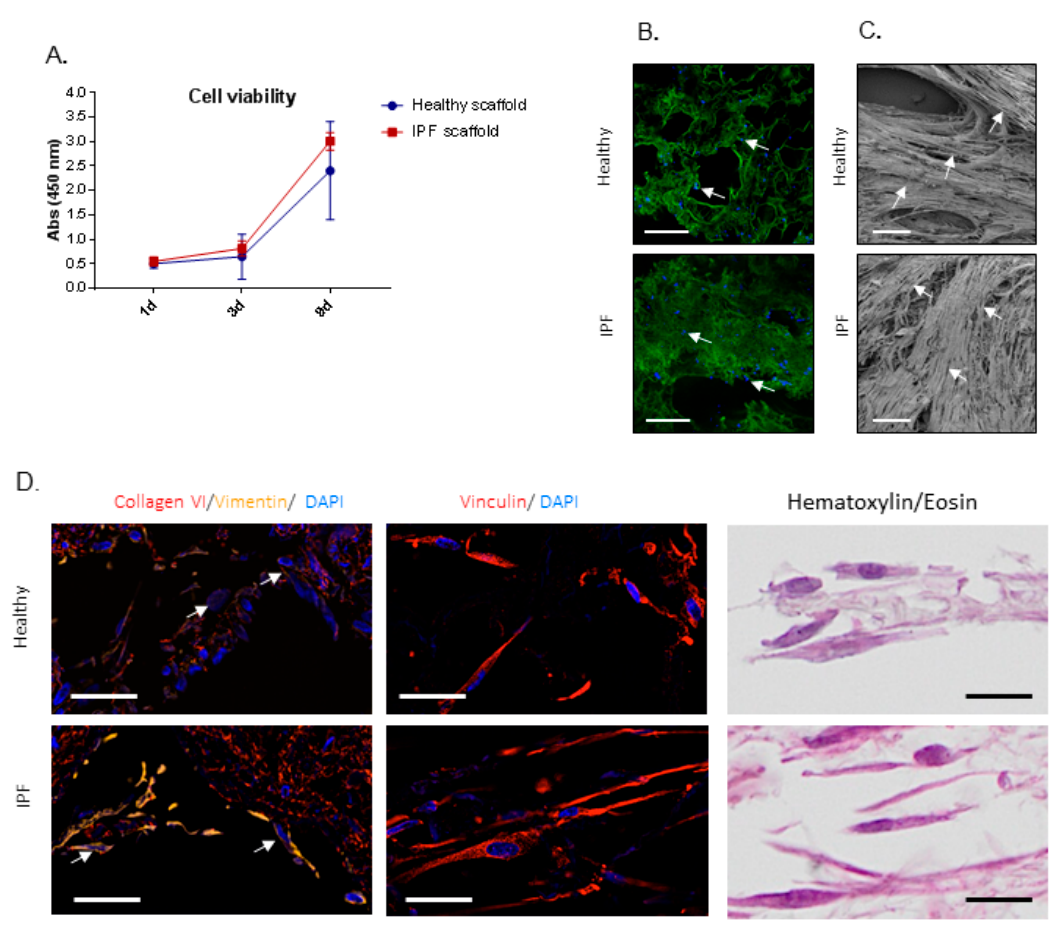
Figure 3. Cell viability and cell attachment of repopulated IPF and healthy tissue scaffolds. ( A ) Cellular viability of primary lung fibroblast repopulated on tissue scaffolds (biological replicates n = 4), shown as mean ± SD. ( B ) Confocal live imaging after 1 day of culture, showing equal cell attachment. Cell staining (blue), autofluorescent scaffold (green). Arrows indicate cells. Scale bar = 500 µm. ( C ) SEM after 9 days of culture, visualizing cellular differences in orientation in the scaffolds and repopulation. Arrows indicate elongated cells. Scale bar = 100 µm. ( D ) Visualization of repopulated scaffolds, showing fibroblasts attaching to the surrounding tissue (here: collagen type VI) and cytoskeleton (vimentin) and patterns of focal adhesions (vinculin). Hematoxylin/eosin staining of corresponding scaffolds shown in the right panel. Arrows: different intensities of vimentin in fibroblasts repopulating healthy vs. IPF scaffolds. Scale bar = 20 µm.